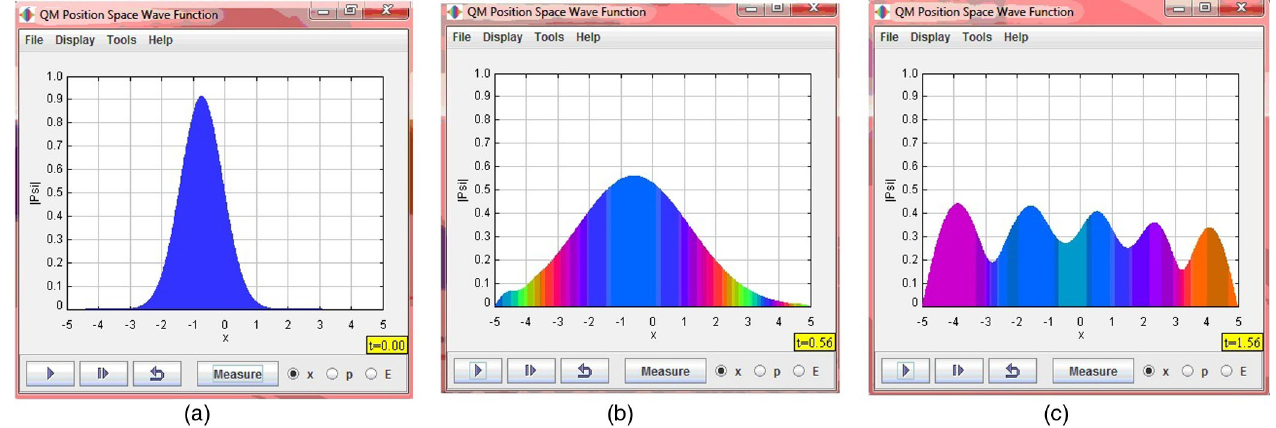
FIG. 7 (color online). Time evolution of the position eigenfunction. (a) The position eigenfunction right after a position measurement. (b),(c) The wave function of the system at later times after the position